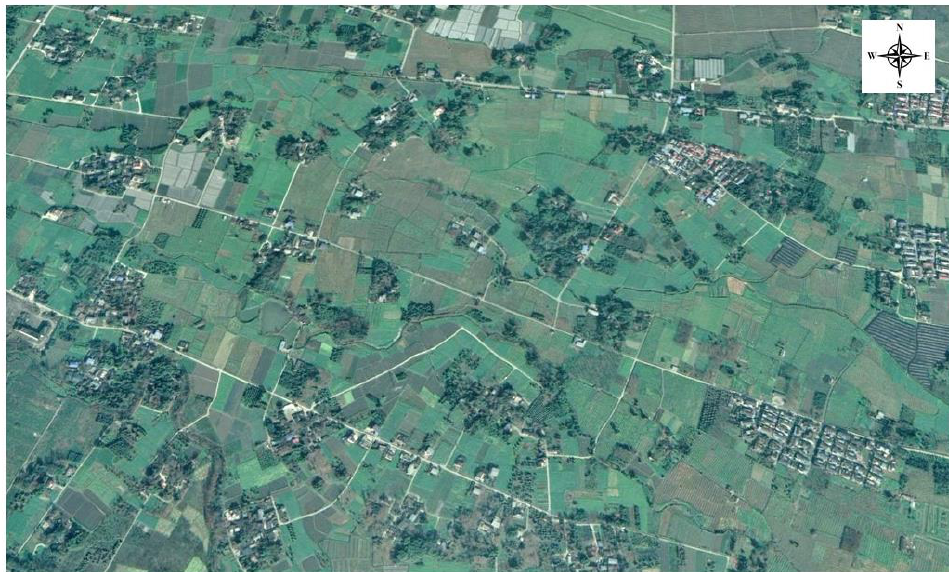
Figure 4. Google Earth image of the linpan landscape on the Chengdu plain as of 2020. Linpans appear as densely wooded clusters of buildings surrounded by fields. Visible also are roadways lined with buildings, as well as modern villages with crisscrossing streets and housing